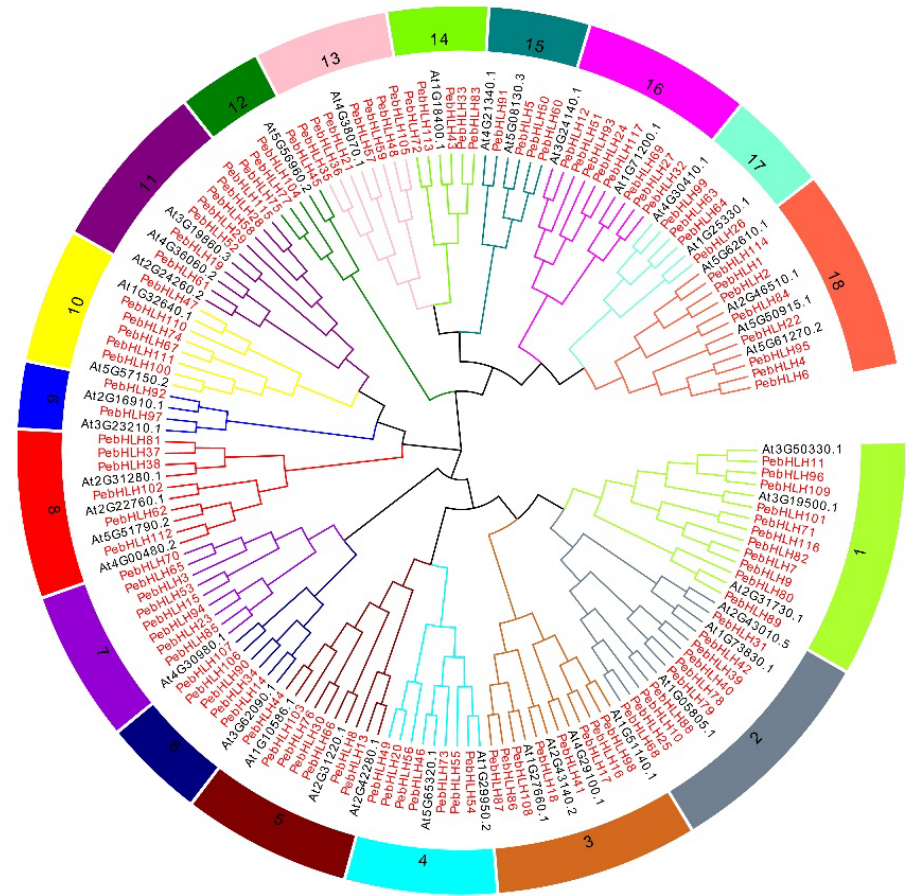
Figure 1. Phylogenetic relationship of bHLHs between passion fruit and Arabidopsis. The different colors of the outer circles represented groups 1–18. Pe and At are abbreviations of passion fruit and Arabidopsis, respectively.